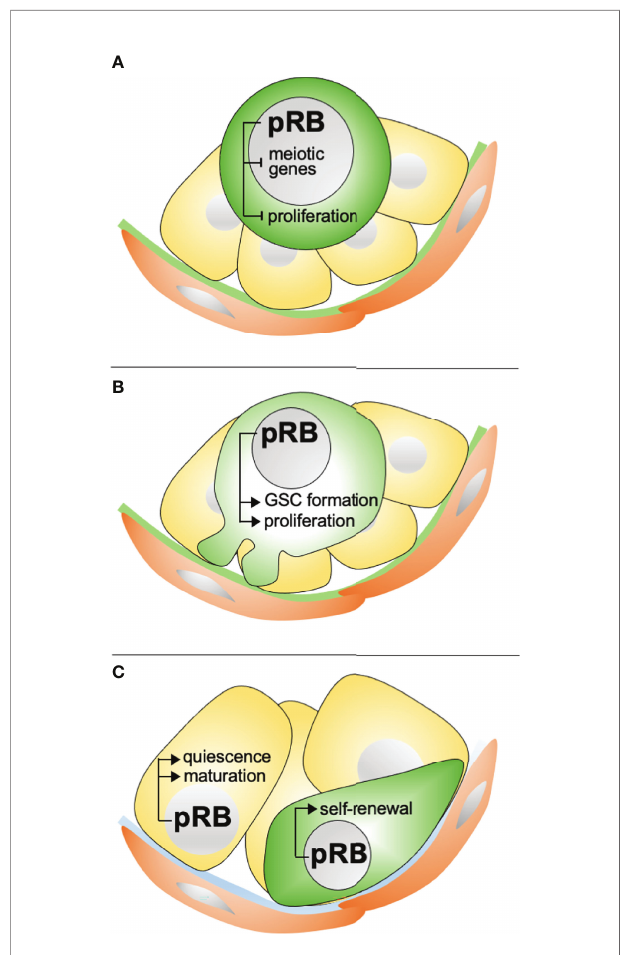
FIGURE 6 | Known developmental roles of pRB in the testis. (A) In ED14.5- 16.5 gonocytes, pRB is needed for cessation of proliferation and entry into a mitotically quiescent state. pRB likely also inhibits the expression of meiotic genes. (B) In the perinatal testis, pRB is needed for cell cycle re-entry and formation of the GSC pool. (C) In pubertal and adult testis, pRB is required for functional maturation of Sertoli cells, including their exit from the cell cycle, and self-renewal of